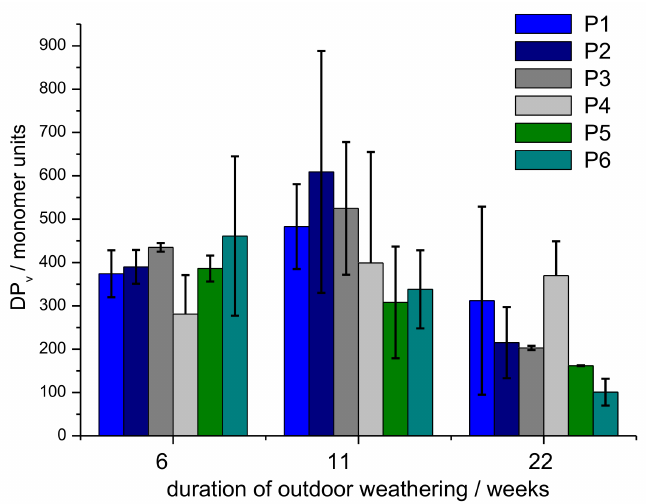
Figure 7. Degree of polymerization of the cellulose as function of time under outdoor